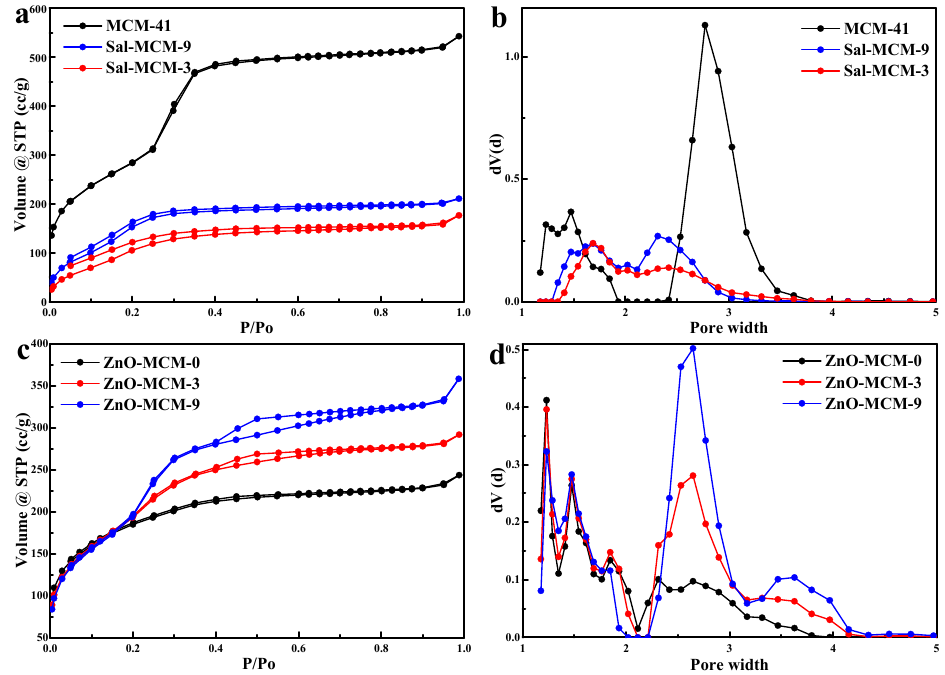
Figure 2. N 2 adsorption/ desorption isotherms ( a , b ) and pore size distribution ( c , d ) of MCM-41, Sal-MCM, and ZnO-MCM.